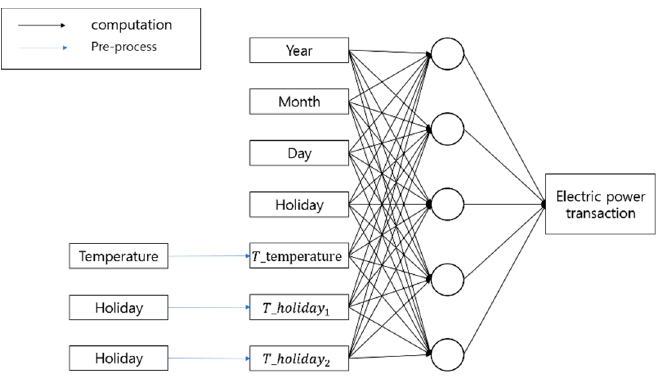
Figure 16. Configuration of MLP-based algorithm to predict the amount of